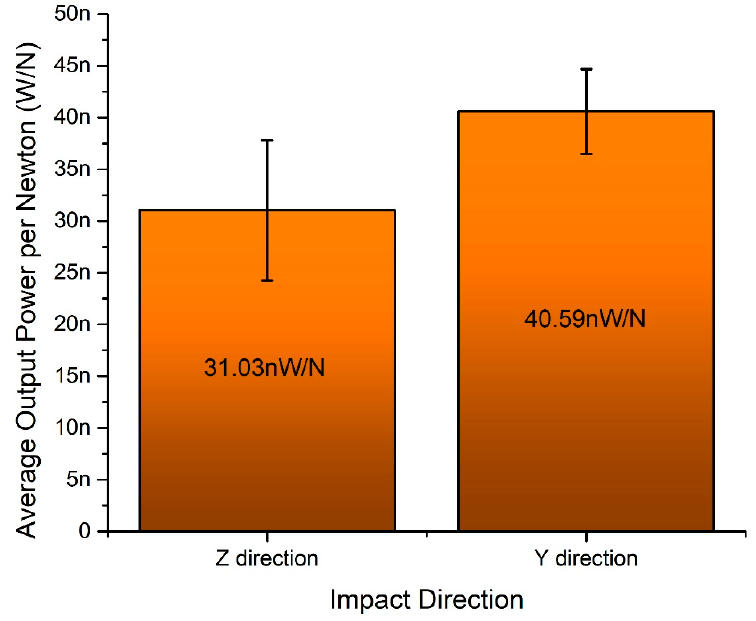
Figure 21. Characteristic of average output power per 1N.